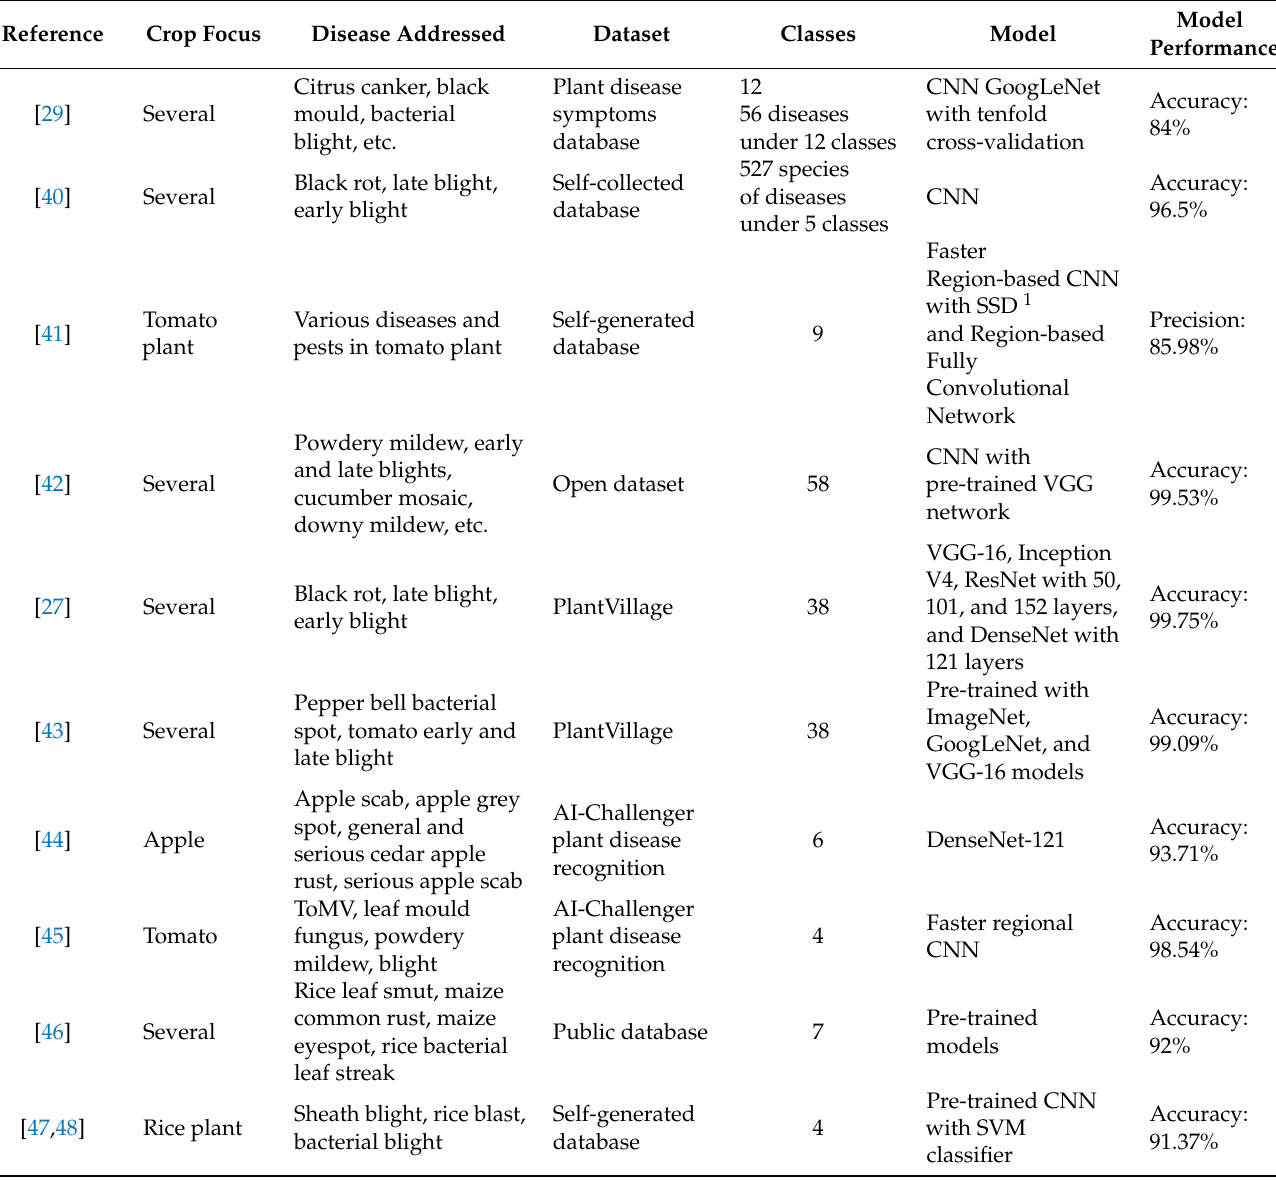
Table 1. Detailed summary of the CNN models used in the recognition and classification of plant